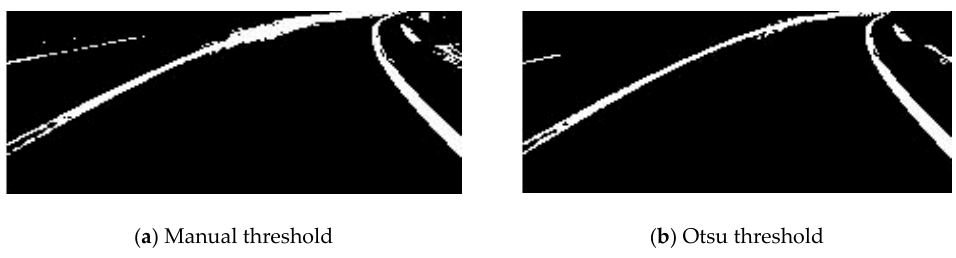
Figure 19. Manual and Otsu threshold from the athletic track lane image.